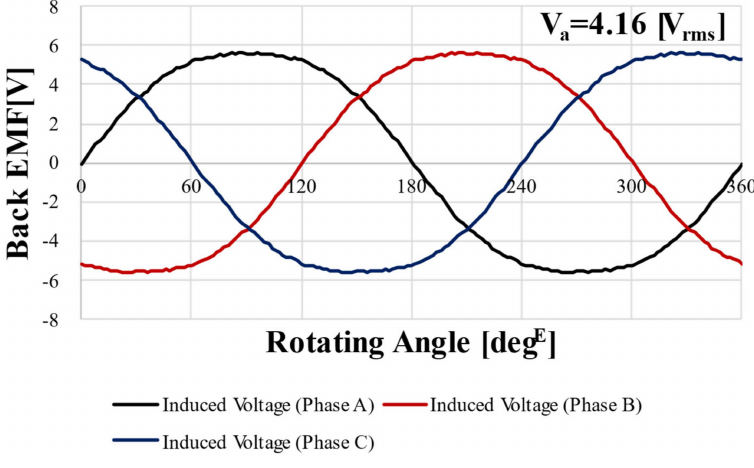
Figure 9. Back EMF FEA result of target RFPM motor @1000 rpm.